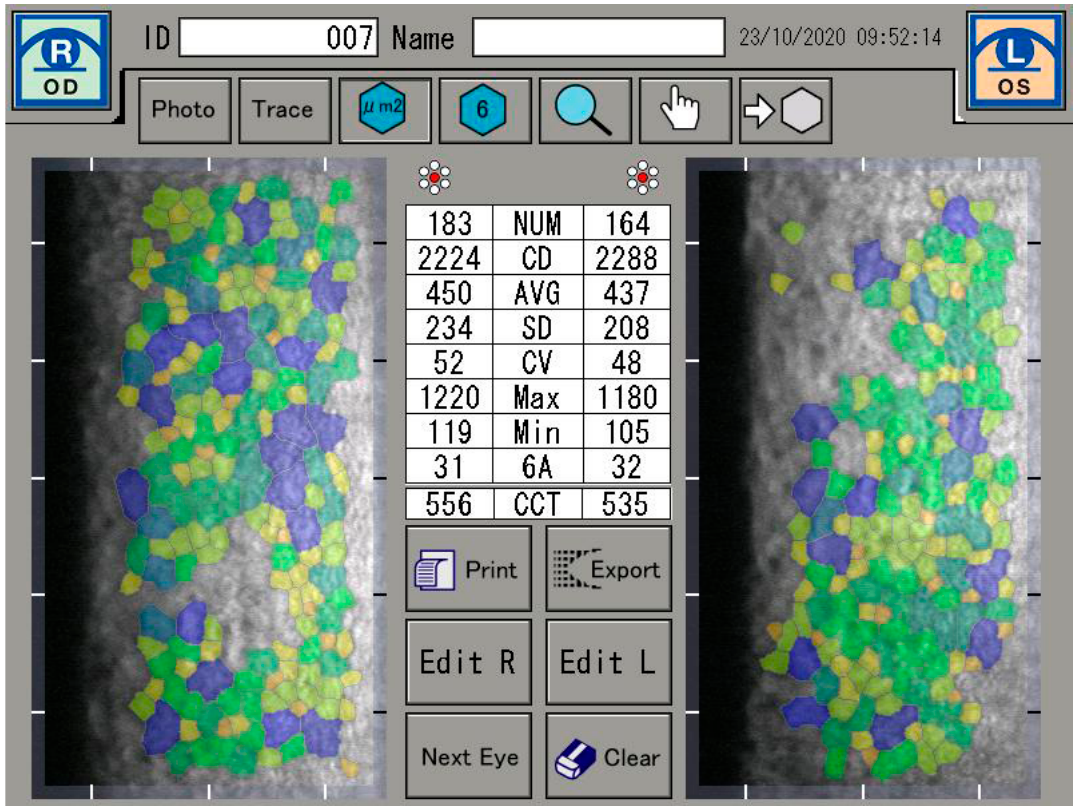
Figure 1. Endothelial cell analysis.